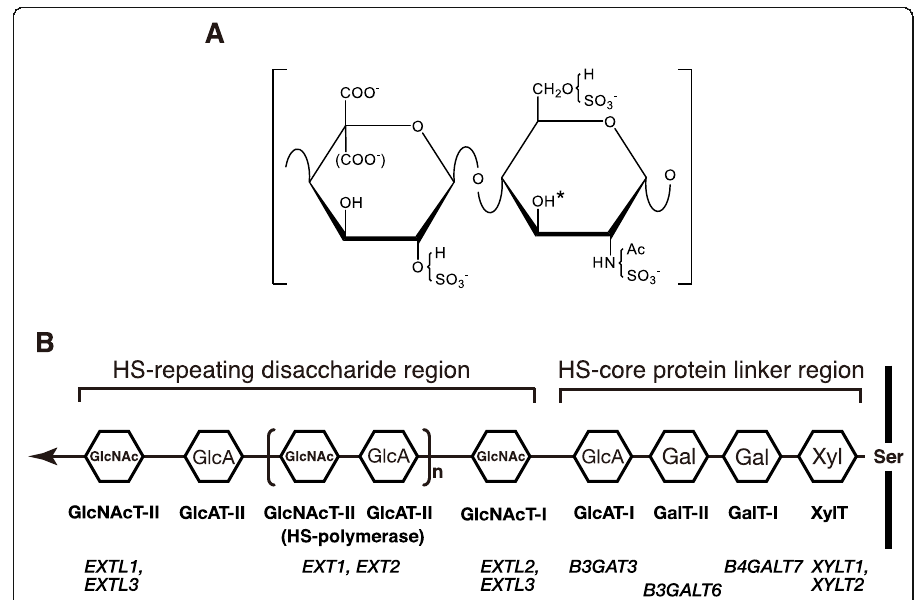
Fig. 1 Structure and biosynthesis of HS. a – The structure of the repeating disaccharide unit in HS. The polysaccharide backbone of HS is composed of an alternating repeat of GlcA/IdoA and D-glucosamine (GlcN): -4GlcA β /IdoA α 1-4GlcN α 1-. The amino group of GlcN is acetylated or sulfated. Hydroxy groups at the C6 of GlcN and the C2 of GlcA/IdoA may be sulfated. The hydroxy group of the C3 position (indicated by an asterisk) of N -sulfated/ N -unsubstituted GlcN residue in specific saccharide sequences is possibly sulfated. b – A schematic drawing of the structure of HS polysaccharides. The enzyme responsible for the transfer of each monosaccharide residue is shown below the corresponding sugar residue. Gene(s) encoding each enzyme are also shown below. The arrow indicates the direction of biosynthesis. XylT, xylosyltransferase; GalT-I, galactosyltransferase I; GalT-II, galactosyltransferase II; GlcAT-I, glucuronyltransferase I; GlcAT-II, glucuronyltransferase II; GlcNAcT-I, GlcNAc transferase I; GlcNAcT-II, GlcNAc transferase